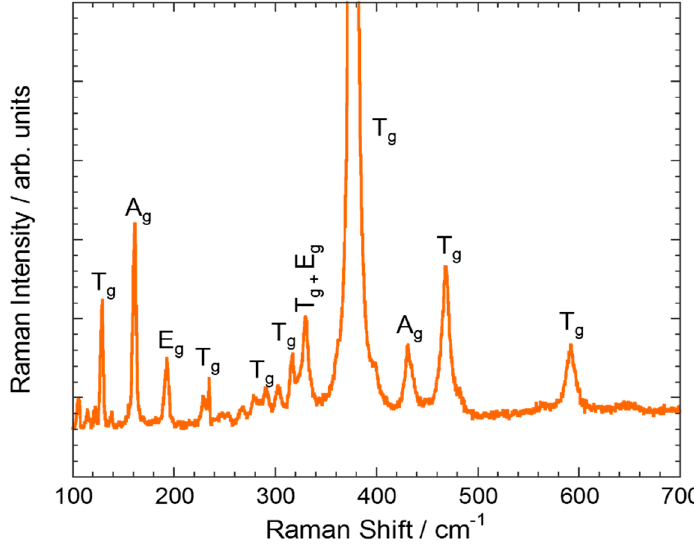
Figure 2. Raman spectrum of Y 2 O 3 : Pr 3 + NCs obtained by solvothermal method at 220 ◦ C followed by calcination at 1000 ◦ C for 4 h. Only the most intense peaks were assigned.